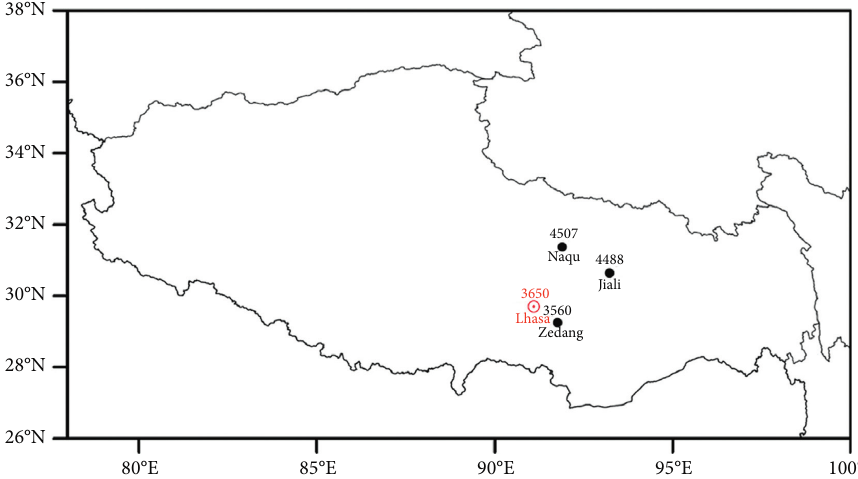
Figure 1: Locations of the study sites. Black solid dots are the three stations, and the red circle is the TAR capital Lhasa; the numbers indicate the altitude (m) at each